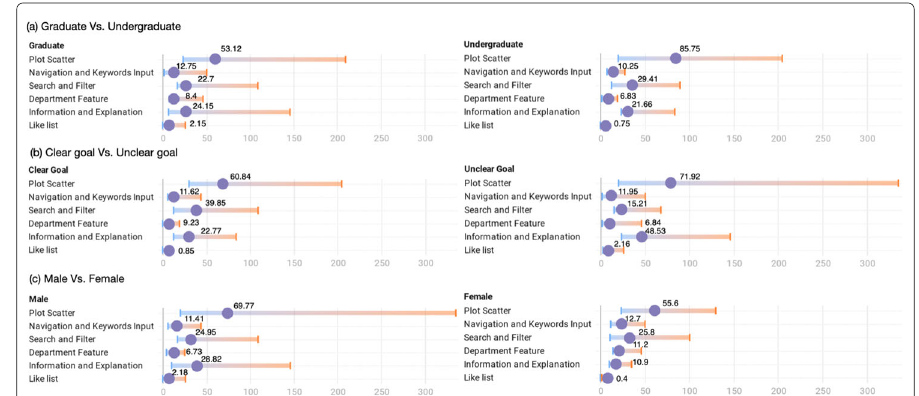
Fig. 9 Interaction results: a Graduate vs. undergraduate. b Clear goal vs. unclear goal. c Male vs. female